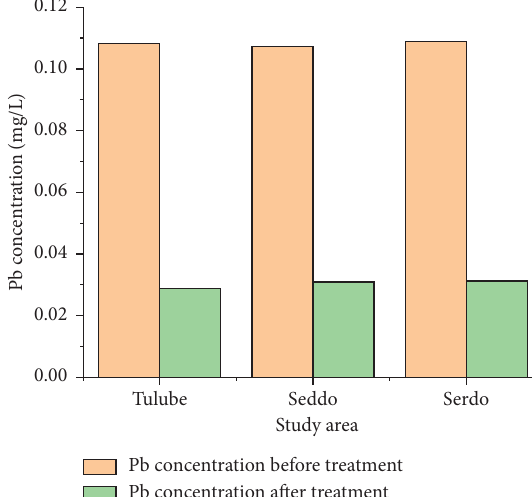
Figure 6: Adsorption of lead ions in drinking water modifed homemade flter media containing banana pseudostem powder, charcoal powder, and sand particles (4h treatment time). Figure 5: Langmuir